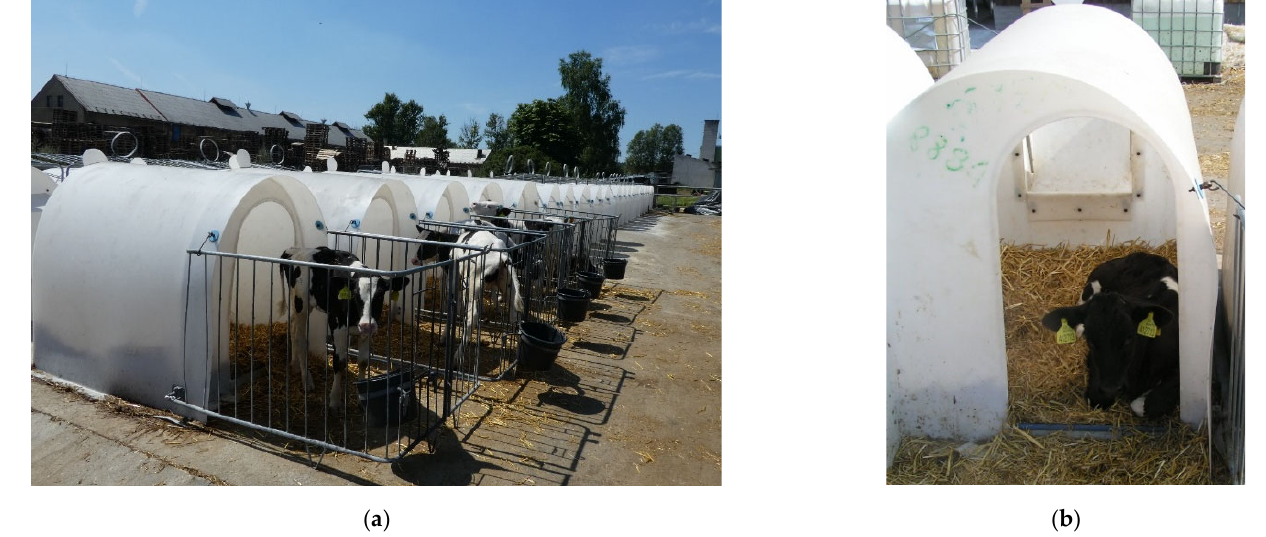
Figure 4. The calf hutches (CaH): ( a ) the group of calf hutches; ( b ) detail of a calf inside the hutch. Three outdoor group shelters (CaS) for older calves from 2 to 4 months of age have a lightweight construction measuring 5.5 m × 4.5 m. The frame is made of steel, and the green cover of the animal shelter is made of very durable PVC material. Usually, 6 to 10 calves are housed in each of them as needed (Figure 5). The floor is covered with deep straw bedding.